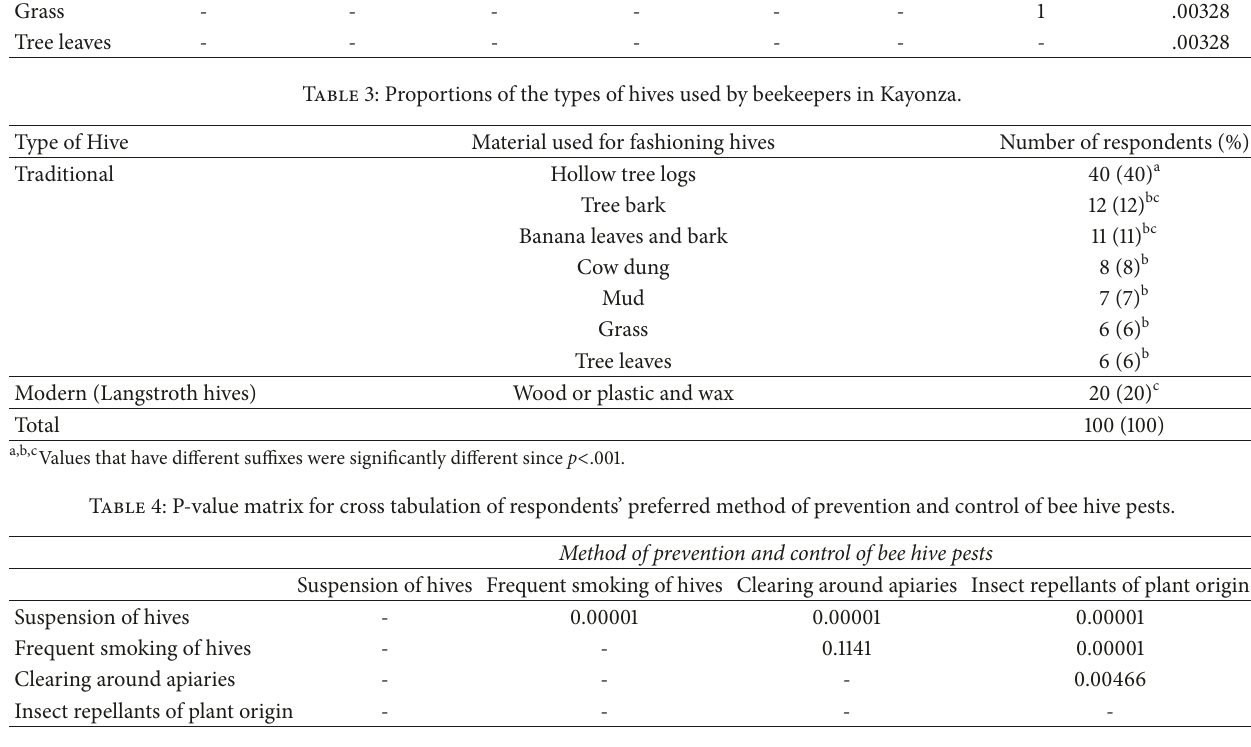
Table 5: Respondents’ methods of choice for pest control and prevention and their perceived